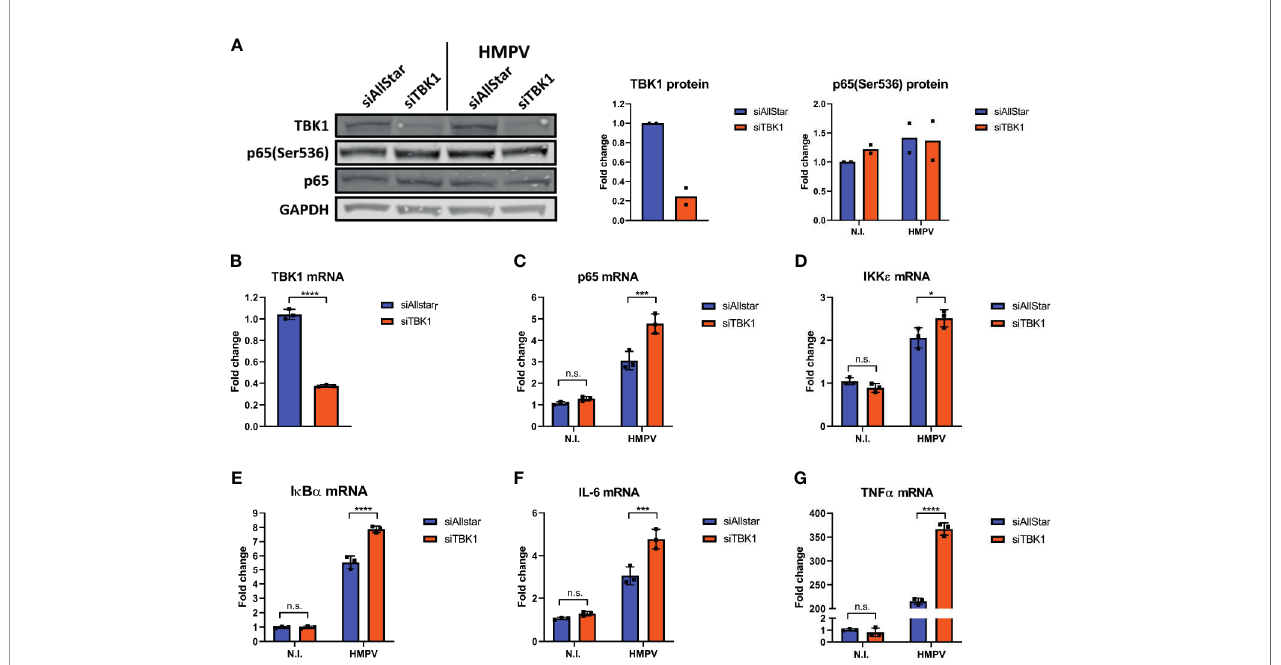
FIGURE 5 | TBK1 is dispensable for HMPV-mediated p65 Ser536 phosphorylation and NF- k B activation. Human MDMs were transfected with TBK1 siRNA or control siRNA («Allstar») prior to infection with HMPV. (A) Whole cell lysates were prepared and protein levels of TBK1 and p-p65(Ser536) were analyzed by immunoblotting. (B-G) MRNA expression of TBK1 (B) , p65 (C) , IKK e (D) , I k B a (E) , IL-6 (F) and TNF (G) was determined by qRT-PCR. Statistical analysis: Two-way ANOVA with Tukey ’ s honest signi fi cance test: ∗ p < 0.05; ∗∗∗ p < 0.001; ∗∗∗∗ p < 0.0001; n.s., not signi fi